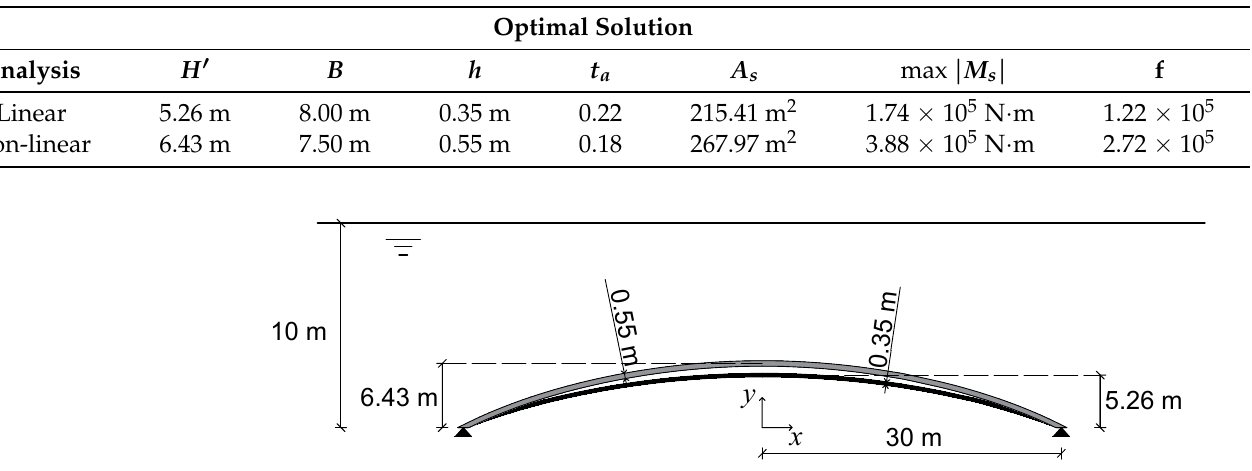
Figure 8. Arch shapes comparative for linear (black) and nonlinear (gray) in the case in which the span B is